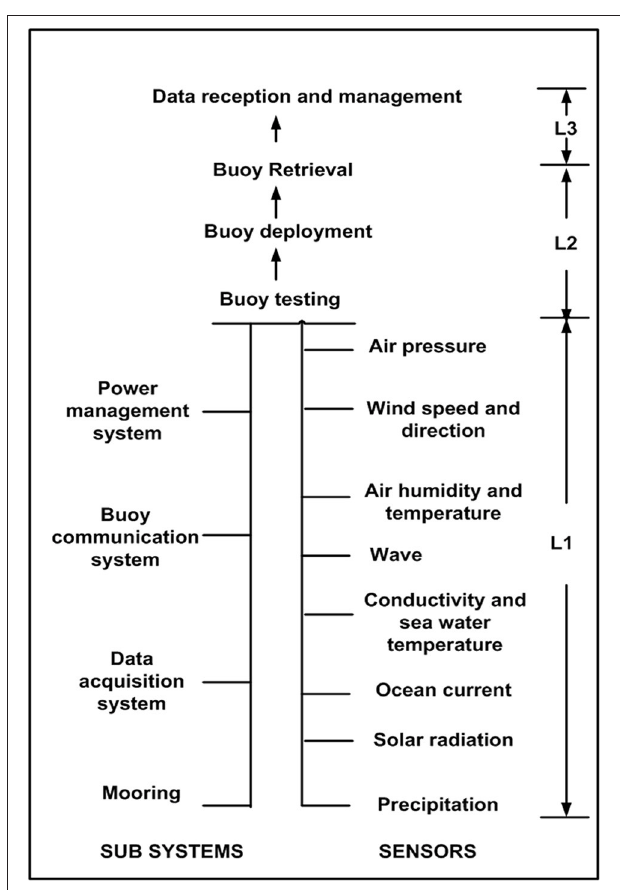
FIGURE 4 | Quality and best practices in buoy system.